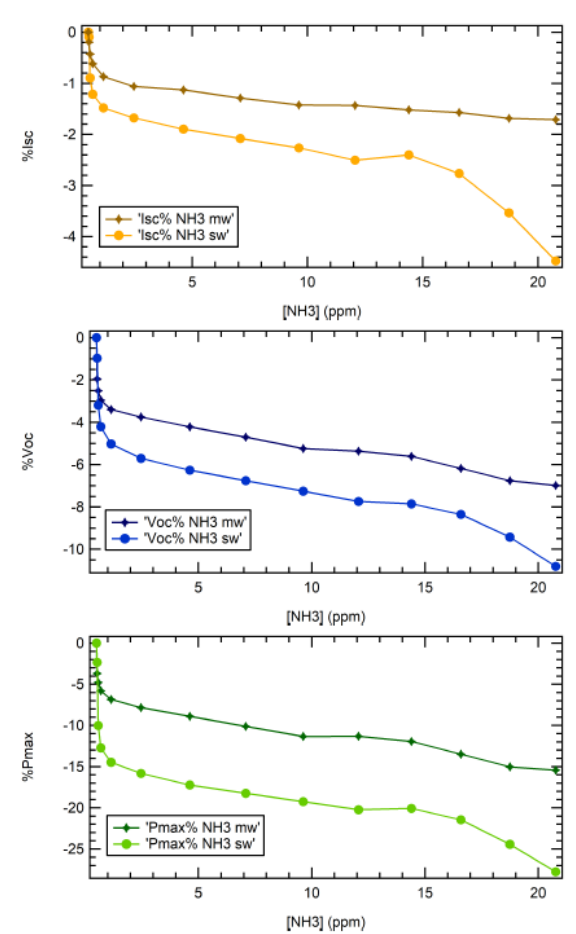
Figure 5. I sc , V oc , and P max dependence on NH 3 concentration (0–21 ppm range) for MWCNT (diamonds) and SWCNT (dots) PV cells. Values are expressed as a percentage of the parameter (I sc , V oc , and P max ) change with respect to the read-out before exposure. All data were collected in the testing chamber.